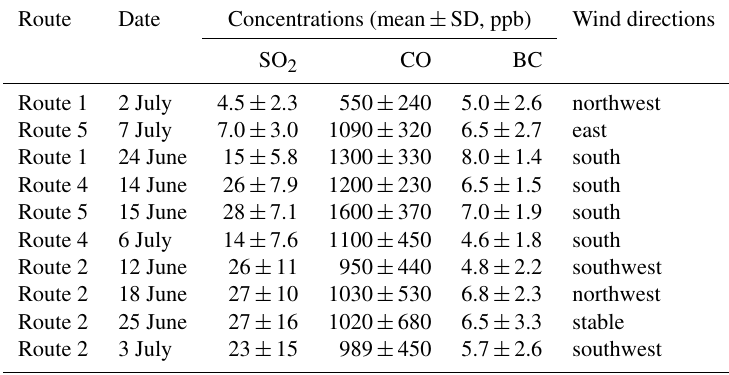
Table 4. Trip-average concentrations of SO 2 , CO and BC and wind directions on the days discussed in the paper.